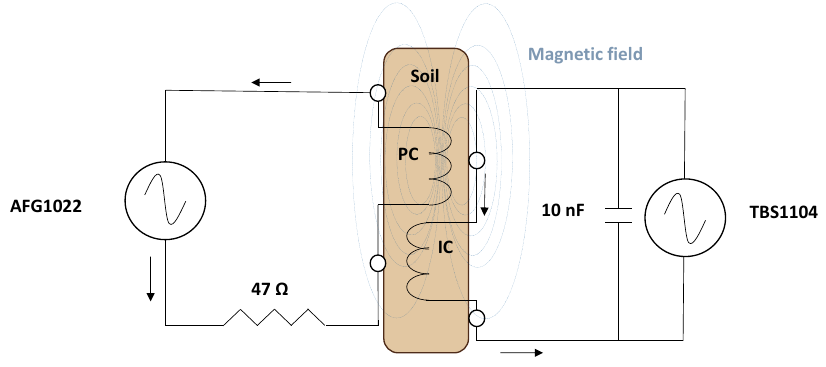
Figure 3. Electric circuit of the sensor.